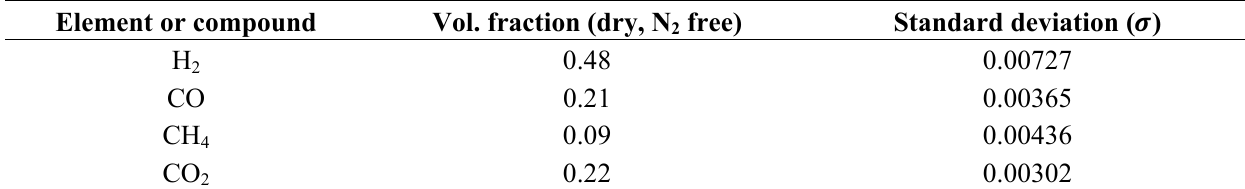
Table 6. Reference composition of the gas obtained by steam gasification of biomass at 850 °C (dry, N 2